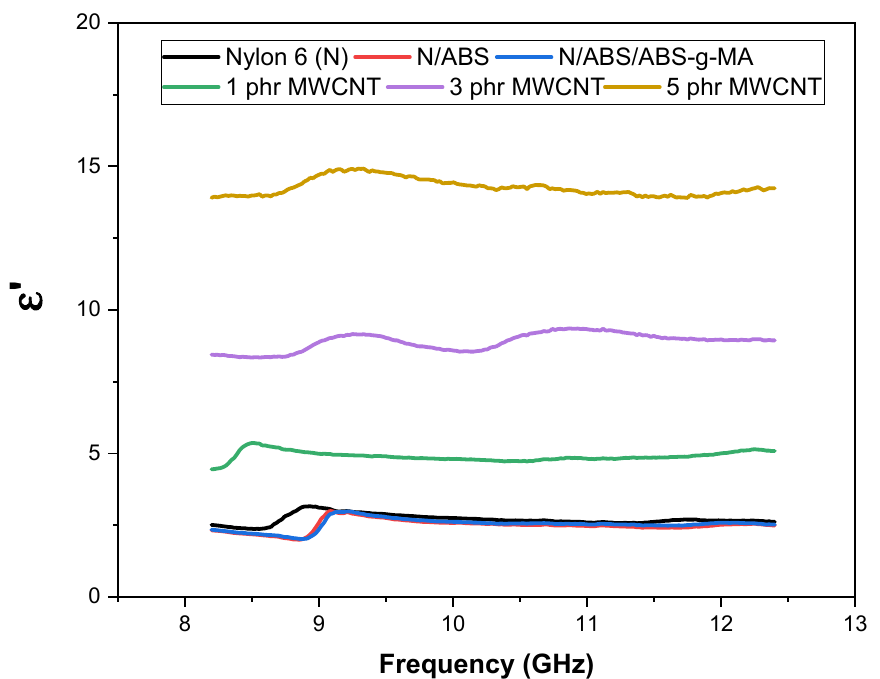
Figure 6. Behavior of the dielectric permittivity as a function of frequency for Nylon 6, blends, and nanocomposites. N = Nylon 6.